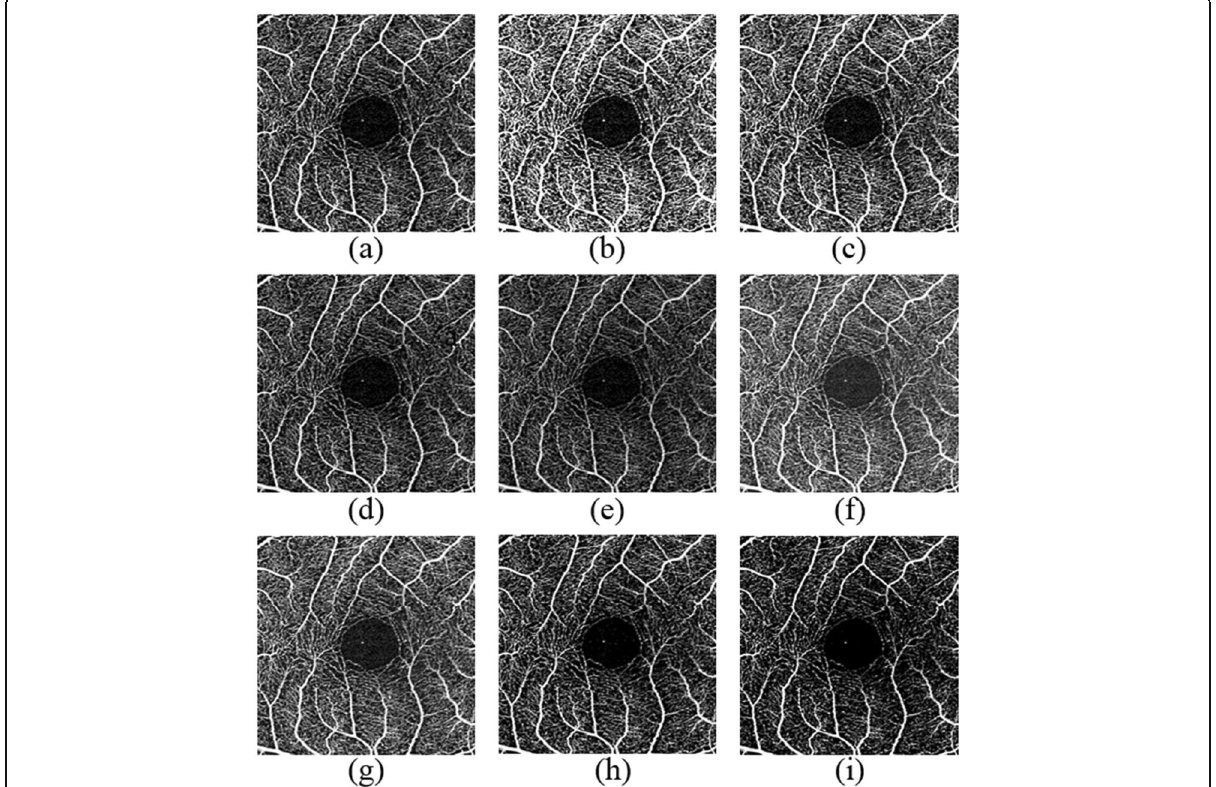
Fig. 2 An example of OCTA images with nine different brightness/contrast settings. a 130/20; b 90/20; c 110/20; d 150/20; e 170/20; f 130/0; g 130/10; h 130/30; i